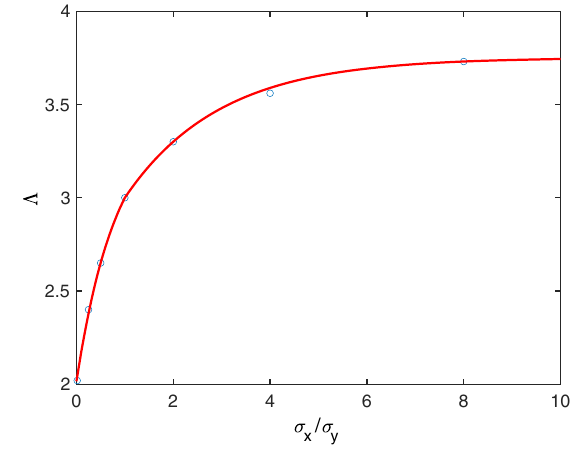
FIG. 7. The coefficient of the residual centripetal force as a function of aspect ratio. The solid line is a fit to exponential curves.